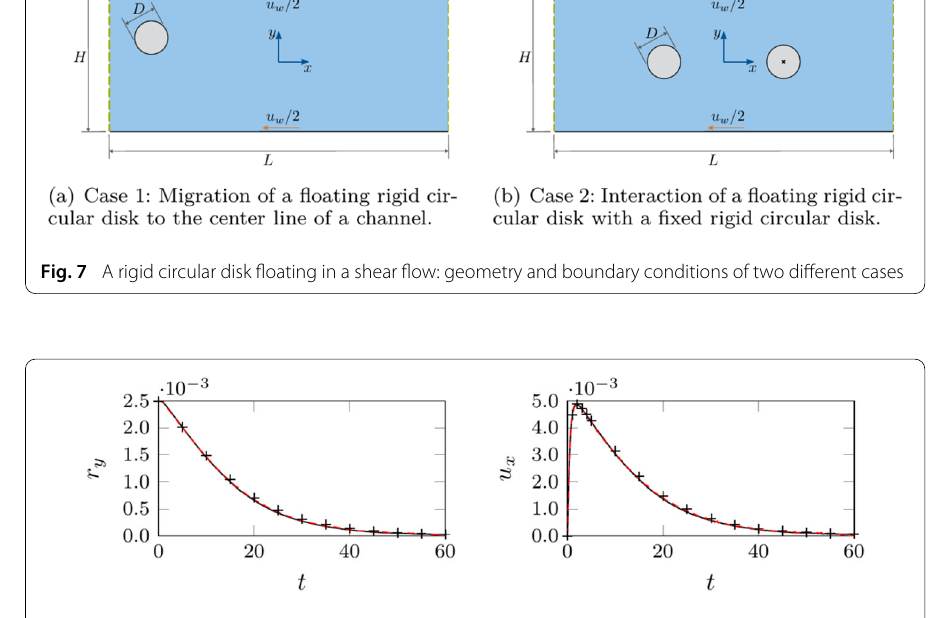
Fig. 8 Migration of a floating rigid circular disk to the center line of a channel: vertical position r y and horizontal velocity u x of the center of the floating circular disk in the channel computed with the proposed formulation and an initial particle spacing of (cid:10) x = 2 . 0 × 10 − 4 (red dashed line) and (cid:10) x = 1 . 0 × 10 − 4 (black solid line) compared to the reference solution [8]